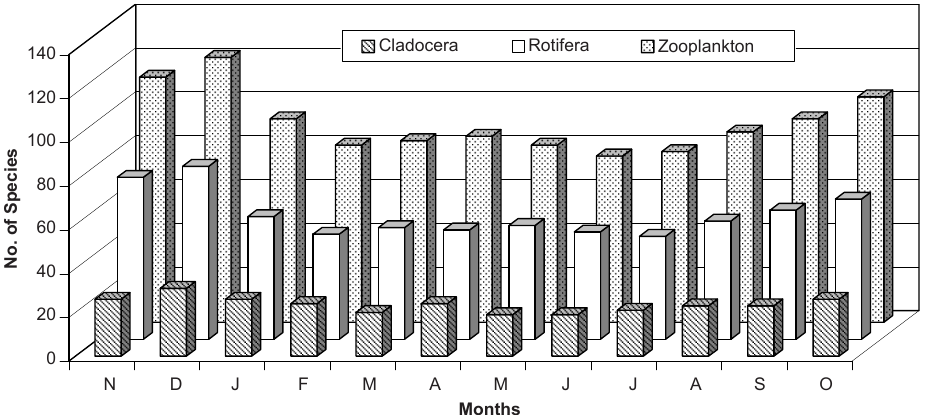
Figure 1. Monthly variations in richness of zooplankton, Rotifera and Cladocera (2002–03)